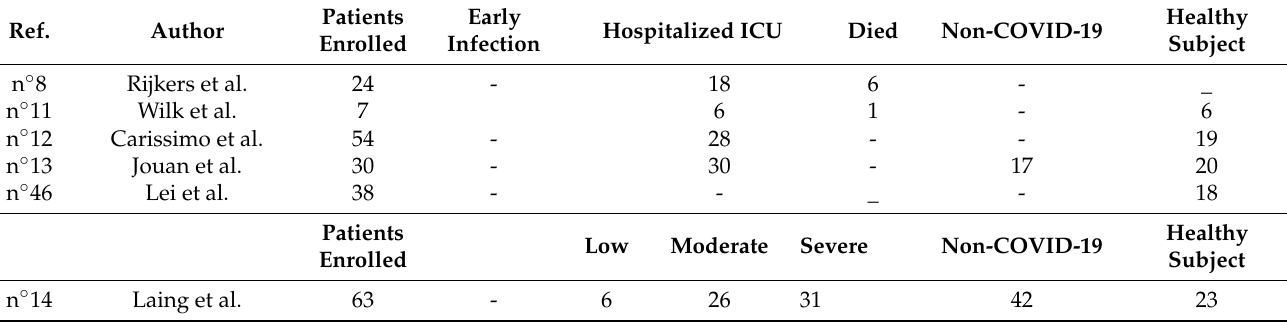
Table 1. Summary of the number of patients and their clinical characteristics in the studies on γδ T cells. Non-COVID-19 patients and healthy subjects have been used as controls.